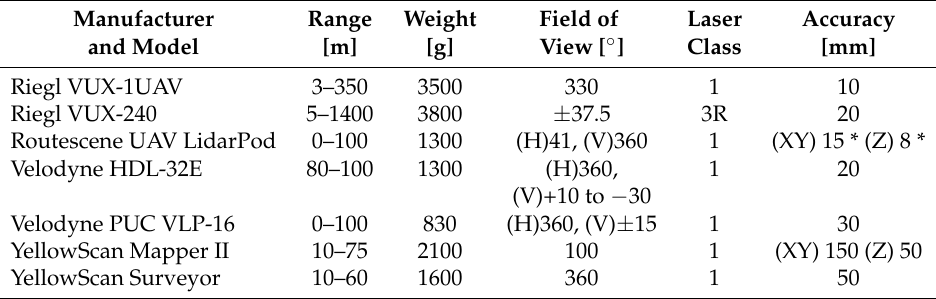
Table 7. Main parameters of some lidar sensors designed for